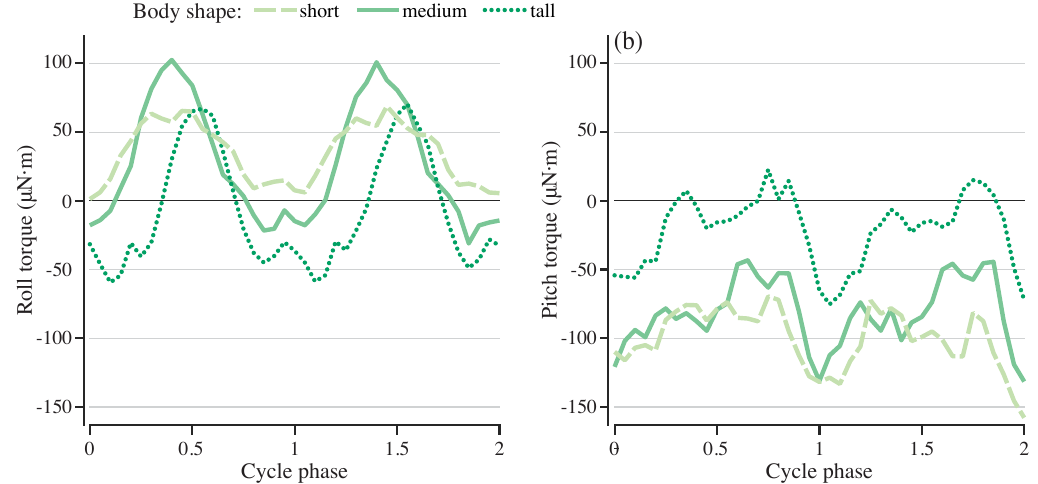
Figure 8. Pitch and roll torques needed to stabilize models with different body shapes. Roll ( a ) and pitch ( b ) torque for stabilization for swimmers with short, medium, and tall